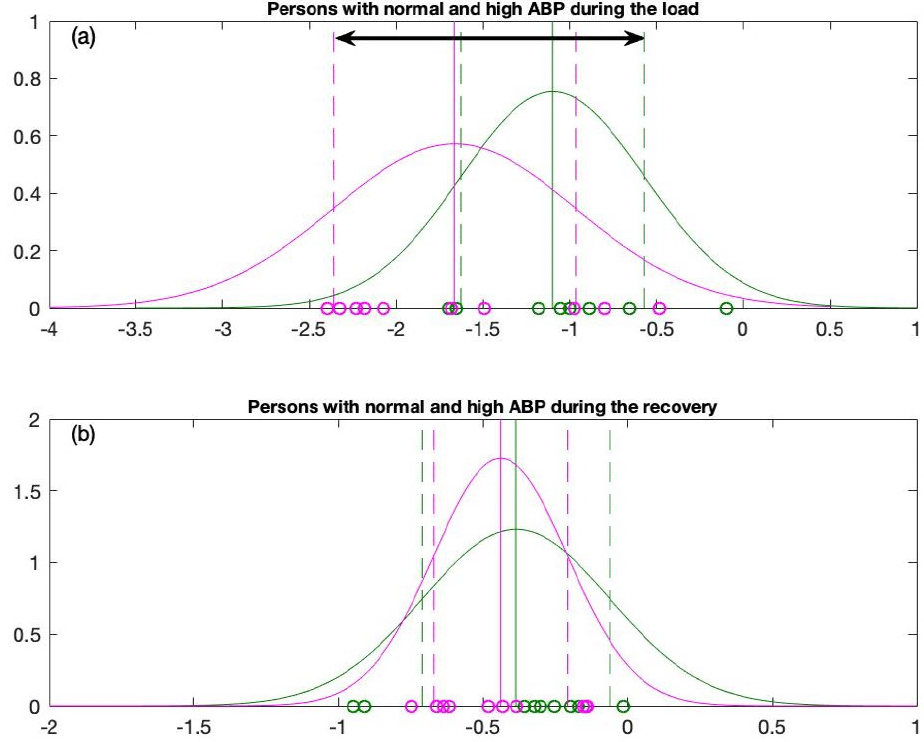
Figure 5. Overall comparison of normal distribution graphs for ( a ) Persons with normal and high ABP during the load and ( b ) Persons with normal and high ABP during the